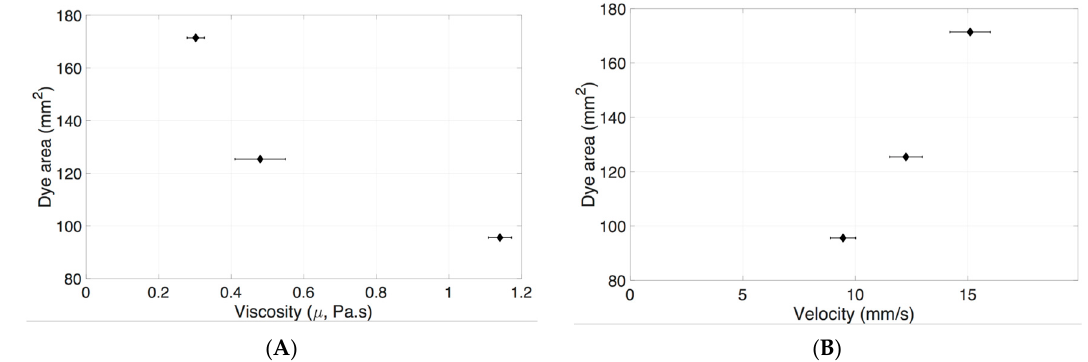
Figure 14. Correlation between bolus dye areas in HA vitreous substitutes. ( A ) Shear-zero viscosity and ( B ) velocity when dye was injected at high Re (677 ± 175).